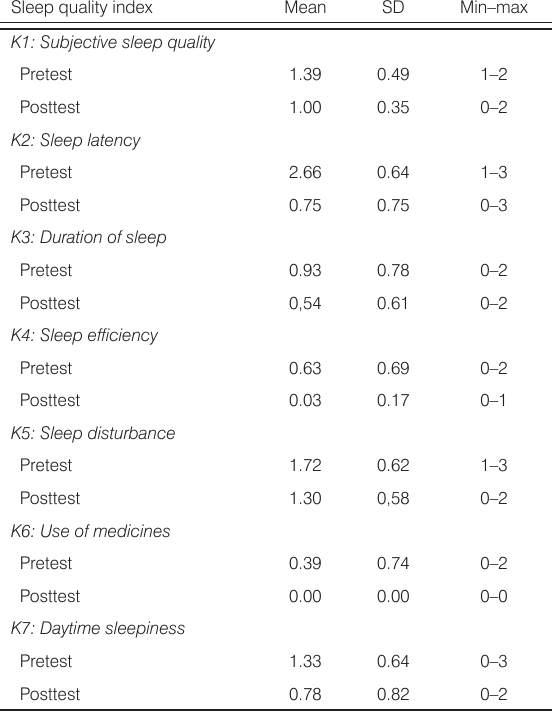
Table 2. Sleep quality in the intervention group ( n =33).